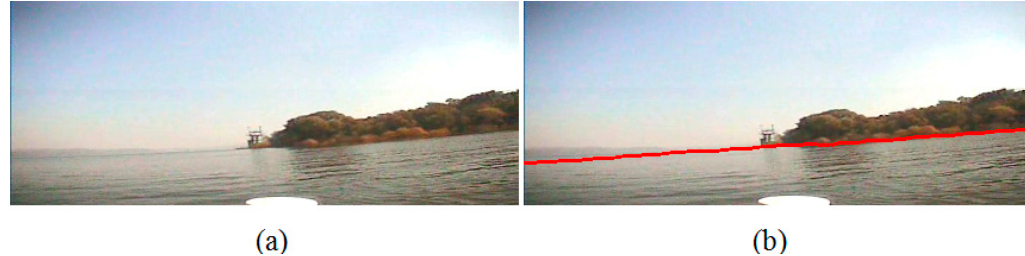
Figure 15. Waterline detection of a far bank. ( a ) The image before our detection; ( b ) The image after our detection.